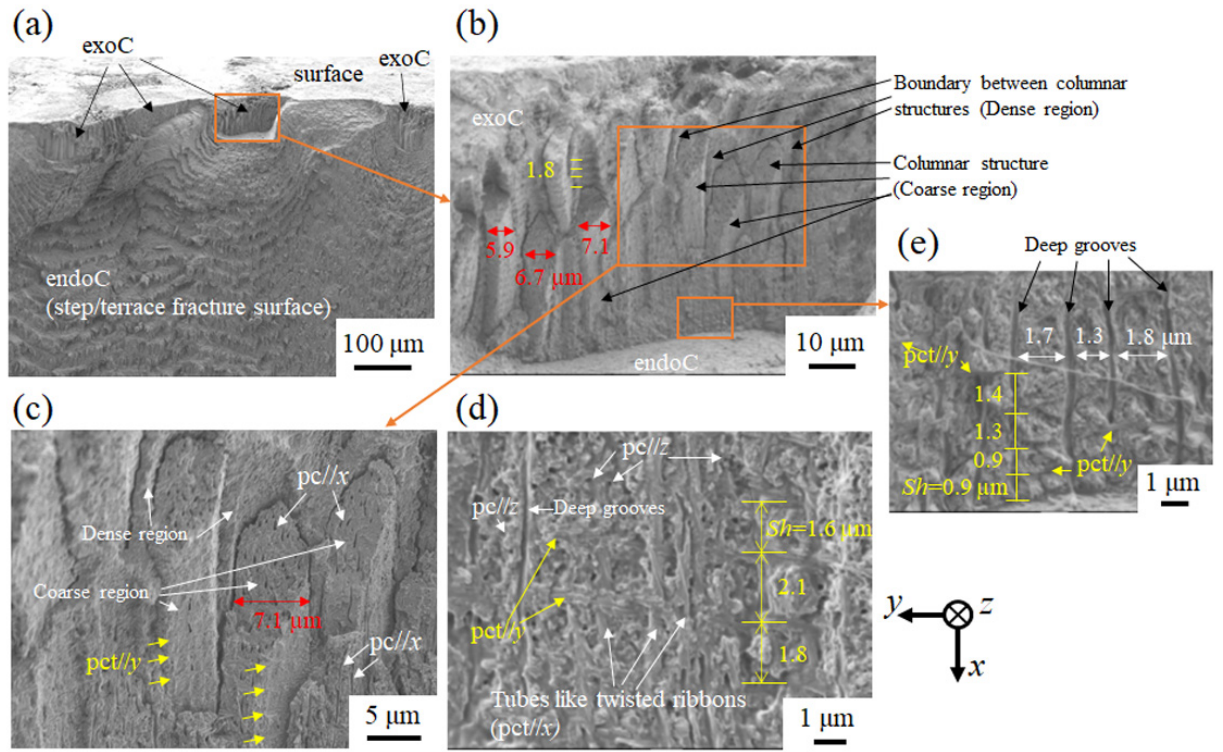
Figure 11. SEM images of the fracture surface in the mottled, deep-blue area. ( a ) Near the surface. ( b , c ) Enlarged views of areas surrounded by rectangles in ( a , b ). ( d ) Enlarged view of the columnar structure face. ( e ) Enlarged view near the boundary between the exo- and endocuticle.